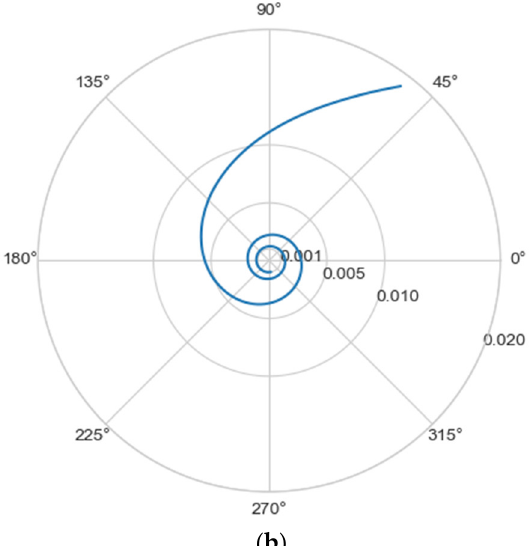
Figure 1. ( a ) Streamlines of the swirling flow in the normal aorta in longitudinal-radial projection. ( b ) Streamlines of the swirling flow in the normal aorta in the axial-radial projection.